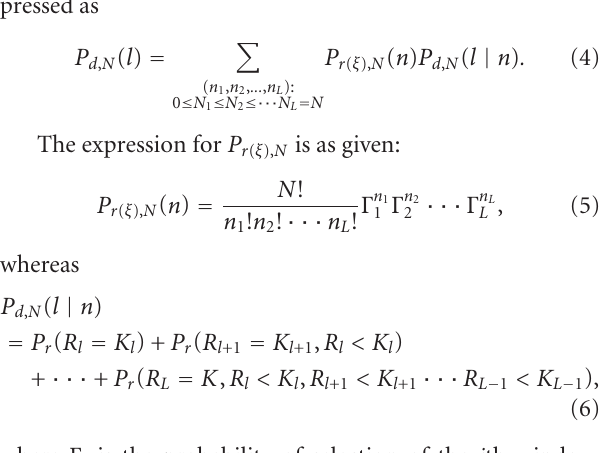
Figure 2: Drop in PSNR for non-IDR slices-Foreman sequence GOP16.